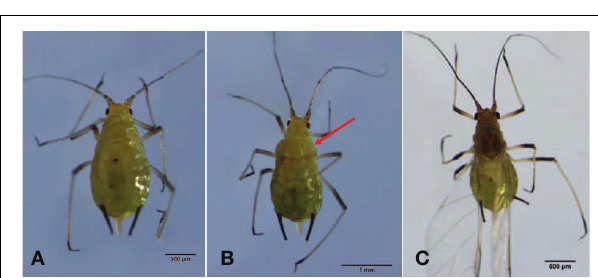
FIGURE 3 | Morphological changes of adult S. avenae after rifampicin treatment. (A) a wingless adult; (B) an intermediate form which should have developed into a winged morph but, instead, retained the sclerotized thorax and wing remnants (arrow); (C) a winged